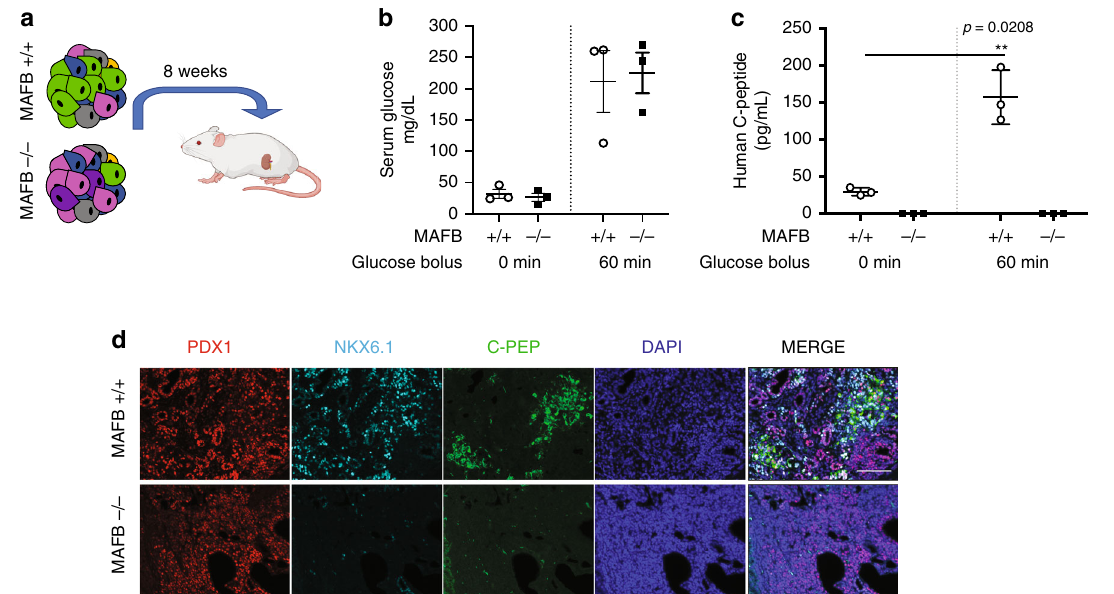
Fig. 3 MAFB is required to generate functional β -cells. a Schematic created with Biorender.com outlining the transplantation strategy to test the functionality of MAFB + / + and − / − β -like cells under the kidney capsule of NSG mice. b Serum glucose measurements from glucose-stimulated insulin secretion (GSIS) experiments at 5 weeks post-transplantation ( n = 3 independent mice). c GSIS experiment at 5 weeks post-transplantation. Experiments were performed one time with three independent NSG mice ( n = 3) per group. P values by paired two-tailed t -test. d Representative IF images from six independent animals (3 MAFB + / + and 3 MAFB − / − ) for C-PEP co-staining with PDX1 and NKX6.1 of grafts removed from kidney capsules 8 weeks post- transplantation. Scale bars, 50 μ m. Data are presented as individual biological replicates and represent the mean ±